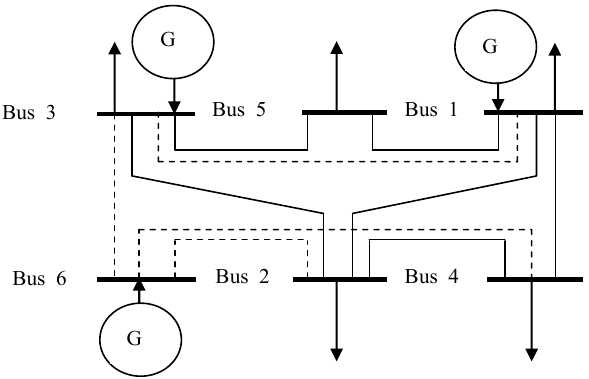
Figure 3. Structure of 6-bus network [47]. Table 1. Load characteristics of 6-bus network [47].